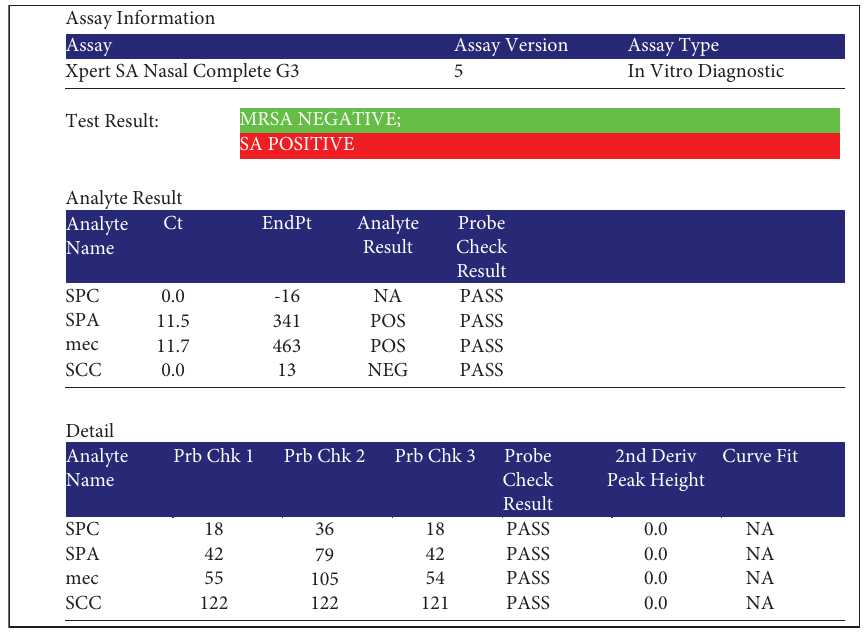
Figure 1: Xpert SA nasal complete G3 of the (mecA) and (SCCmec) MRSA negative result.